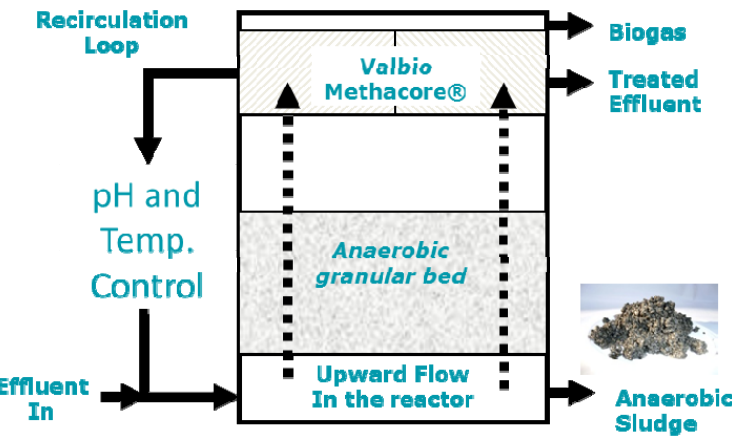
Figure 9. Valbio’s Methacore anaerobic digestion system (fluidized bed) with anaerobic granular sludge used in different units of effluent treatment [132].